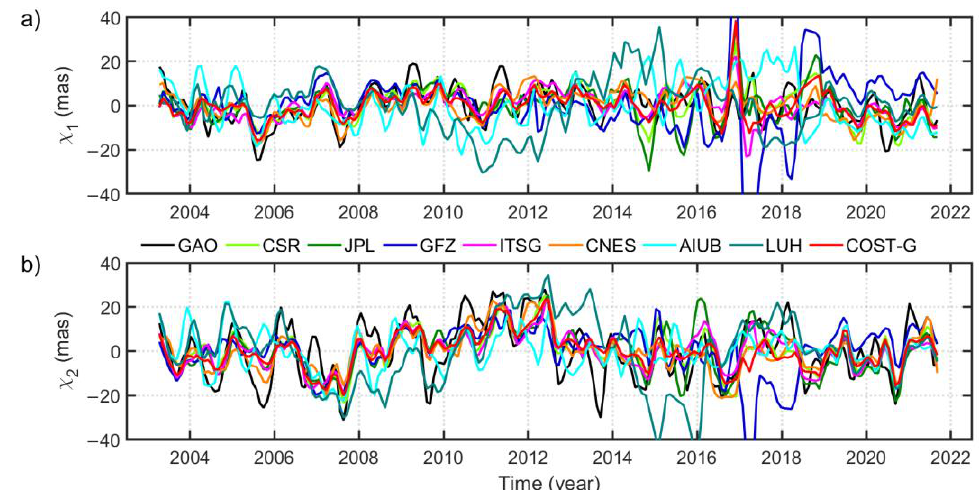
Figure 1. Time series of χ 1 ( a ) and χ 2 ( b ) components of GAO, gravimetric excitation determined from seven GRACE/GRACE-FO single solutions (CSR, JPL, GFZ, ITSG, CNES, AIUB, and LUH) and one combined solution (COST-G) after filling a near-year data gap between the end of GRACE and the start of the GRACE-FO operation. The series were filtered using a Gaussian filter with full width at half maximum (FWHM) equal to 60 days. The linear trends determined with the use of the least- squares method were removed from the series.